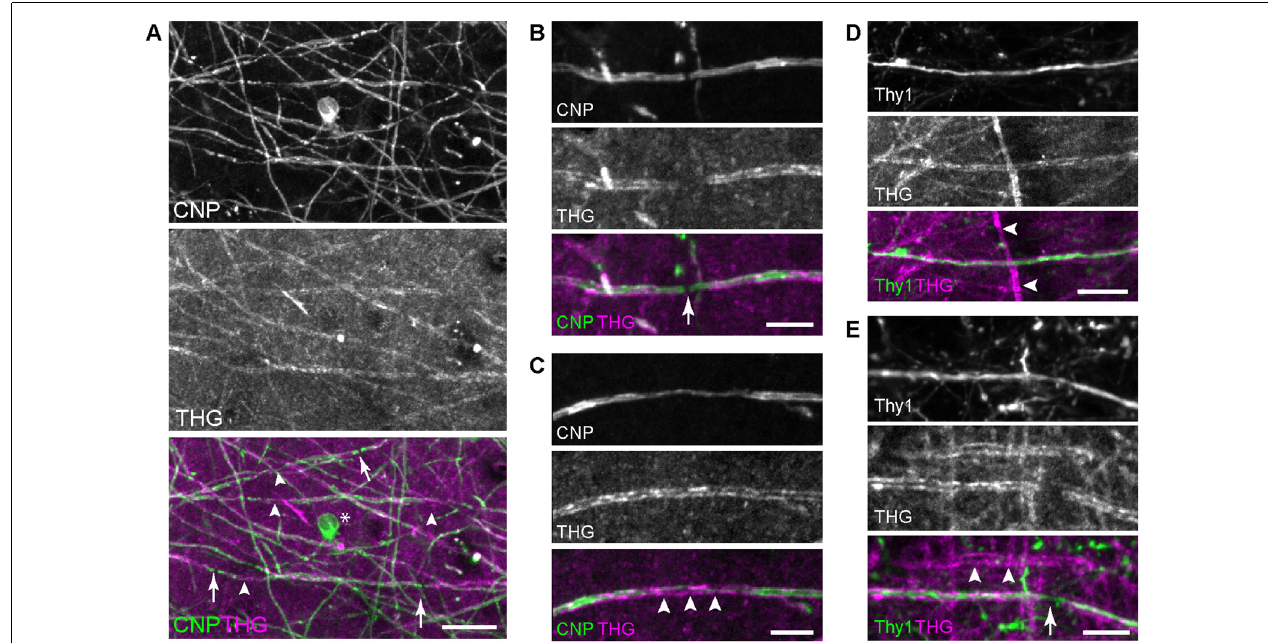
FIGURE 1 | Imaging the whole brains of 2 (cid:48) ,3 (cid:48) -cyclic nucleotide 3 (cid:48) phosphodiesterase (CNP)-green fluorescent protein (GFP) and Thy1-yellow fluorescent protein (YFP) mice. (A) Co-registration of CNP-GFP and third-harmonic generation (THG), with the node of Ranvier (arrows) and compact myelin where CNP tapers (arrowheads). The cell body is also labeled by CNP-GFP (*). Scale bar, 20 µ m. (B,C) A magnified view around the node and the compact myelin, respectively. Scale bars, 10 µ m. (D,E) Myelinated Thy1+ cells with the node (arrow) showing axoplasmic Thy1 within the THG gap. Thy1- cells can be also myelinated (arrowheads). Scale bars, 20 µ